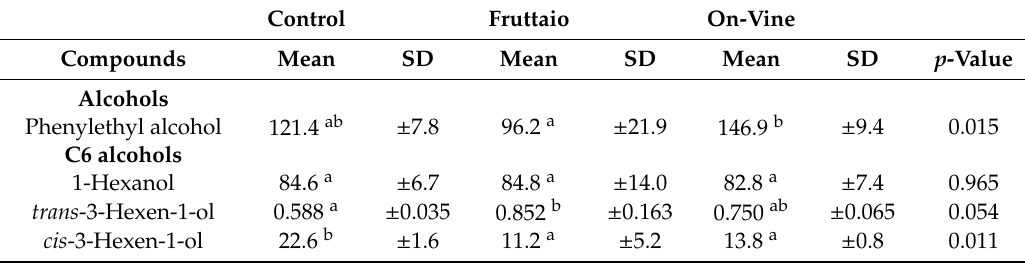
Table 4. Concentration ( µ g / L) of bound compounds in aged wine samples. Mean, standard deviation (SD) and